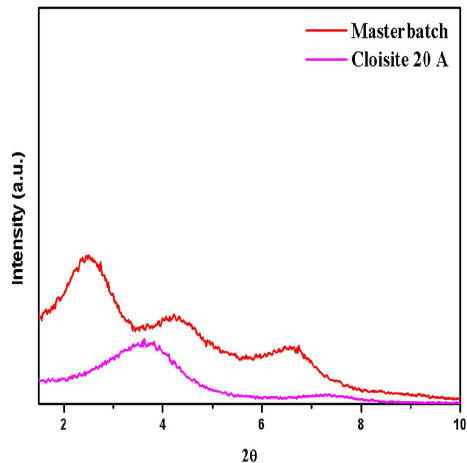
Figure 2. Clay (Cloisite 20A) and concentrate ( masterbatch) of MMO/gMA/Eru XRD